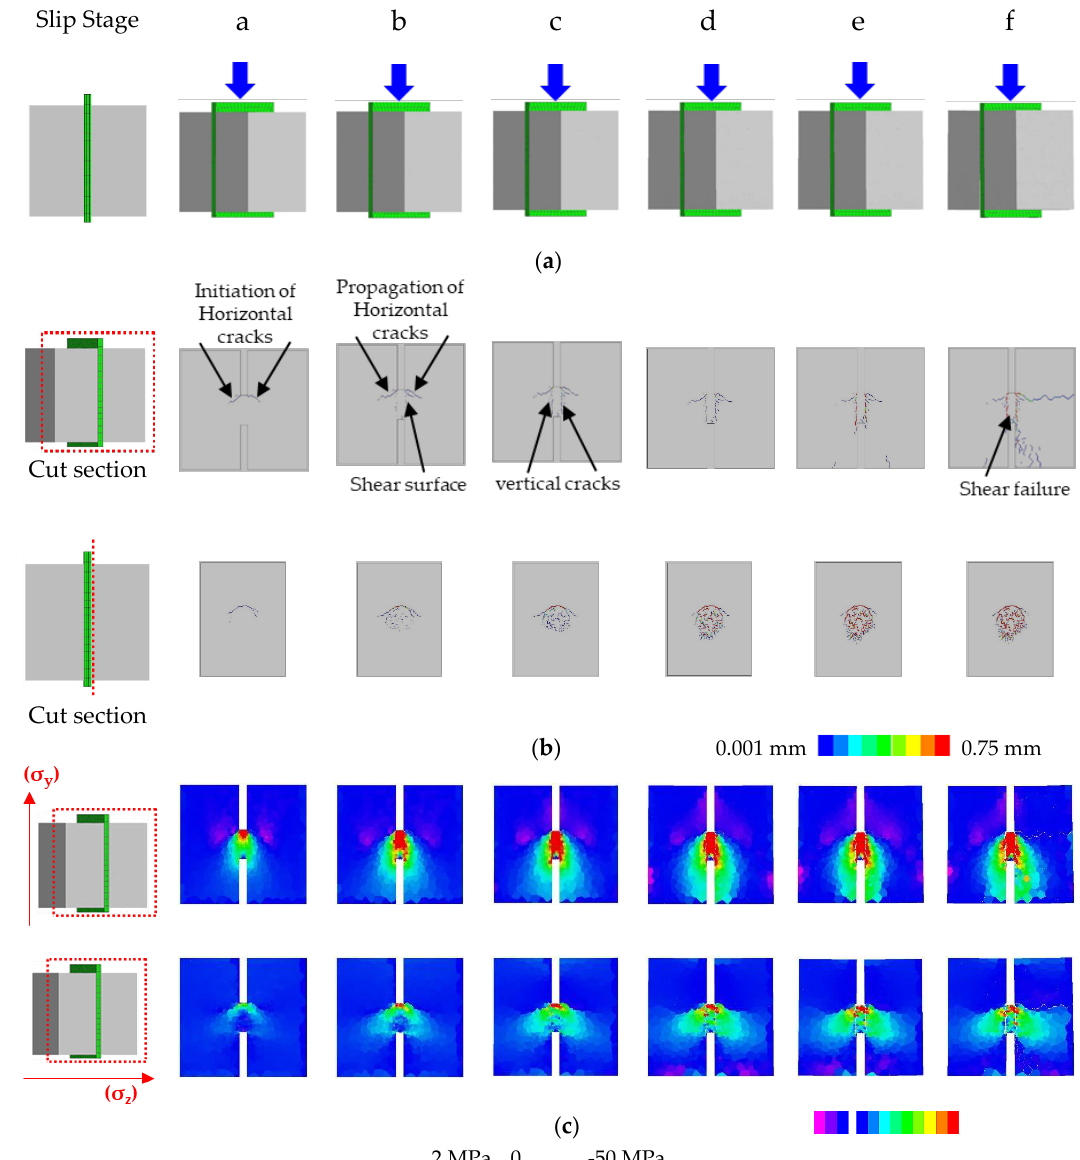
Figure 11. Detailed failure process and mechanism for low lateral pressure case: ( a ) Surface-deformed behaviors (×5); ( b ) Internal crack patterns at cut sections perpendicular and parallel to the thickness of the steel plate; ( c ) Normal stress distribution along with height ( y -axis: direction corresponding to the application of push-out force) and width ( z -axis: direction corresponding to the application of lateral pressure) at a cut section perpendicular to the thickness of the steel plate.